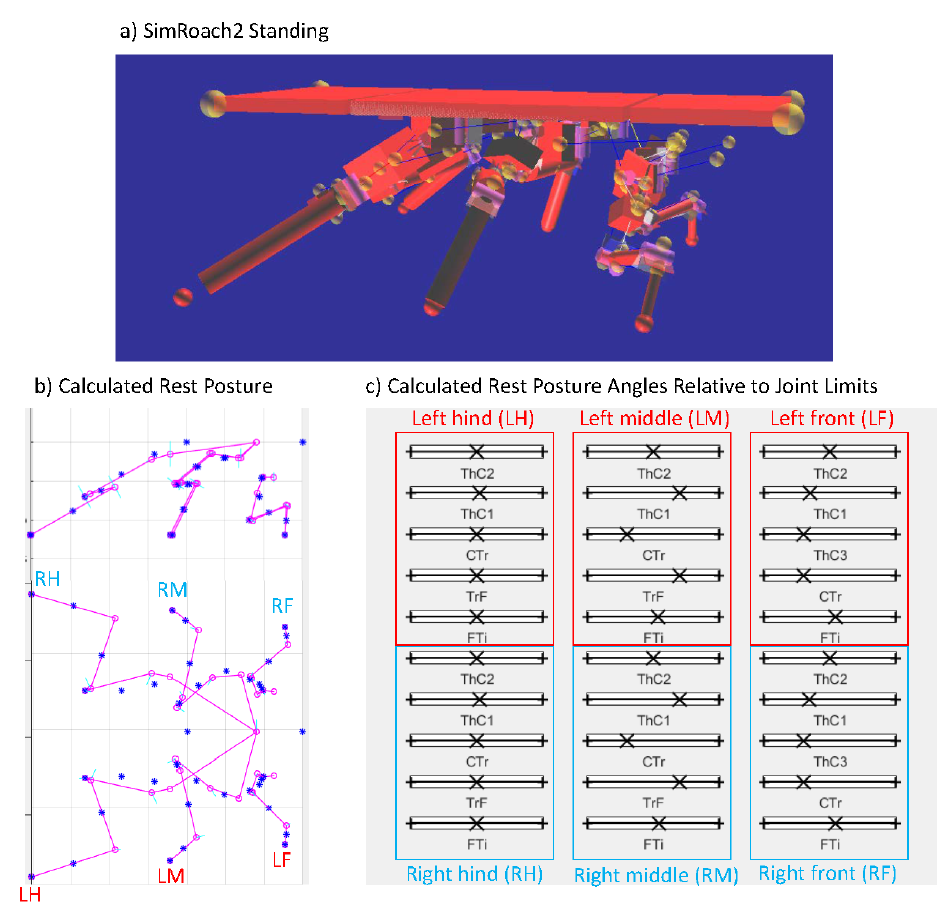
Figure 7. Resting posture of SimRoach2. ( a ) Screenshot of SimRoach2 standing in AnimatLab 2; ( b ) rest posture of SimRoach2 calculated in MATLAB; ( c ) graphical representation of x , the rest posture angle of each joint relative to its joint limits. No joint’s rest posture angle is near its joint